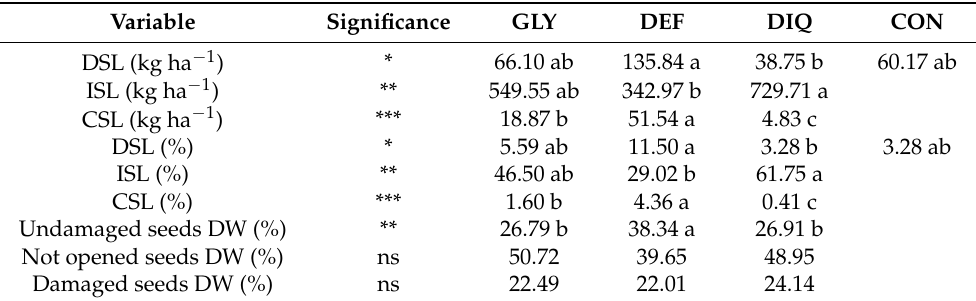
Table 2. Effects of Glyphosate, Spotlight and Diquat on mechanical harvesting of hybrid Kaiima C1012 castor beans. Seed loss due to dehiscence (DSL), impact of the header (ISL) and cleaning shoe (CLS); and dehulling capacity of the cleaning